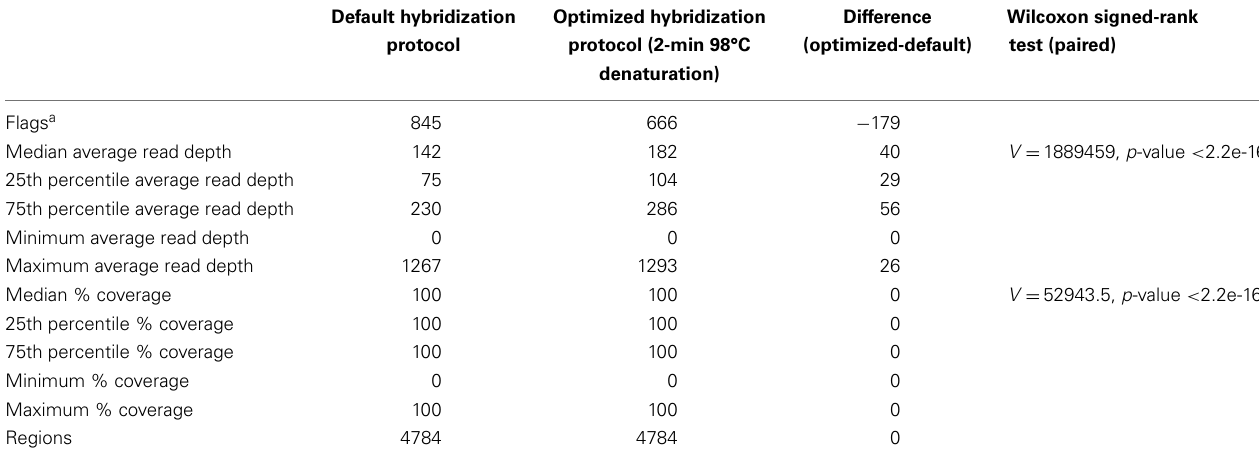
Table 4 | Descriptive statistics for average read depth and % coverage per region for two samples run in parallel using the default and optimized hybridization protocol .